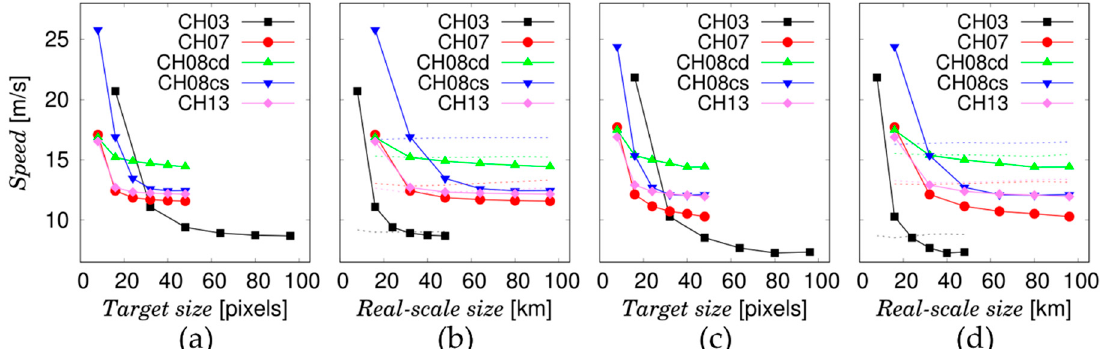
Figure 4. Plots of the mean speed of the collocated GK-2A AMVs against Global Data Assimilation and Prediction System (GDAPS) versus ( a ) target box size and ( b ) real-scale target box size for July 2016 and those against rawinsonde versus ( c ) target box size and ( d ) real-scale target box size for the same period. Each solid and dotted curve in ( b ) and ( d ) represents the mean speed of the collocated AMVs and the corresponding reference data, respectively. The results obtained for January 2016 were similar.